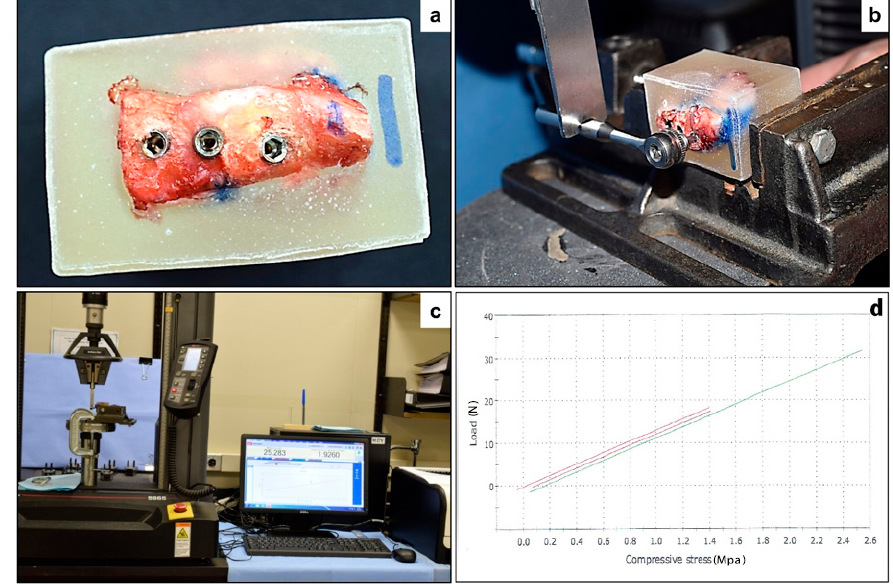
Figure 2. Biomechanical testing of the implants—( a ) Iliac crest specimen embedded in an acrylic mold, with exposure of the implant bearing surface. ( b ) The INSTRON instrument was used to apply downward force on a lever arm (hand wrench) attached to the implant through a suitable coupling (hexagonal drivers). ( c ) The force was carried out with a load cell of 5 kN and a speed of 5 mm/min. ( d ) Maximum load (N) was selected to present the results of mechanical testing as for the three types of implants.